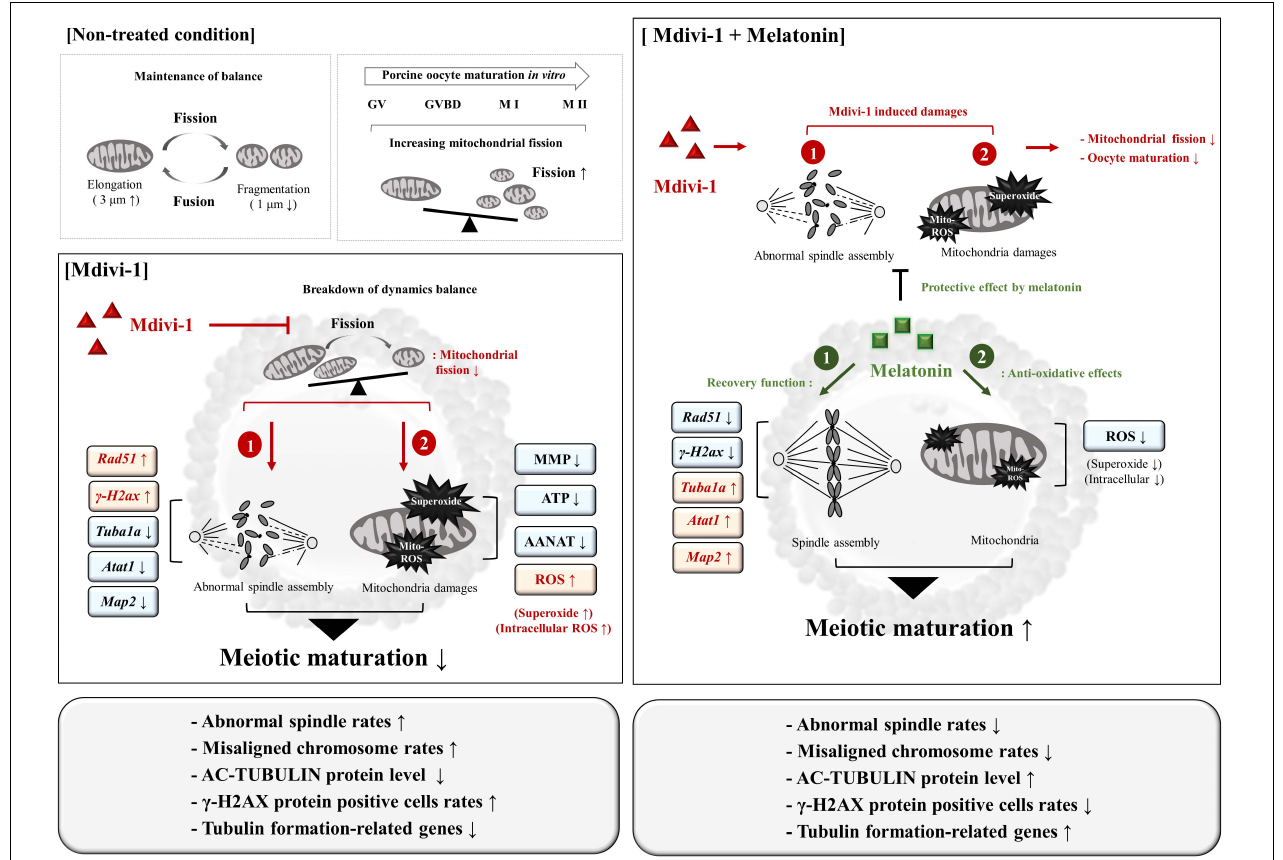
FIGURE 9 | Schematic diagram indicating the suggested protective effects of melatonin on Mdivi-1-inhibited mitochondrial fission in porcine oocytes. In non-treated conditions, mitochondrial fission and fragmentation ( < 1 µ m) increased during oocyte maturation. The Mdivi-1-exposed oocyte increased abnormal spindle assembly (Mdivi-1-induced damage, 1) and mitochondria-derived superoxide assembly (Mdivi-1-induced damage, 2) by blocked mitochondrial fission in pig. Melatonin enhances oocyte maturation capacity against Mdivi-1-mediated damages through restoration of spindle assembly (melatonin recovery effect, 1) and anti-oxidative effector (melatonin recovery effect, 1). Melatonin improves meiotic maturation in Mdivi-1-exposed oocytes as a recovery and protective effect of mitochondrial superoxide and abnormal spindle assembly during